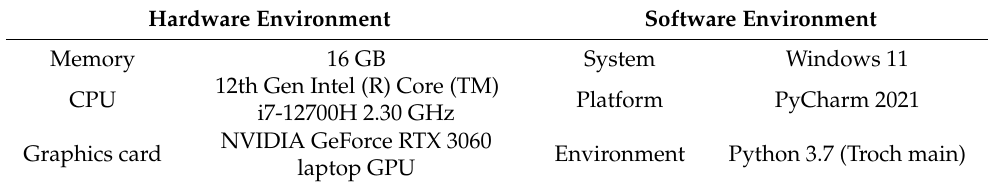
Table 2. Experimental environment .